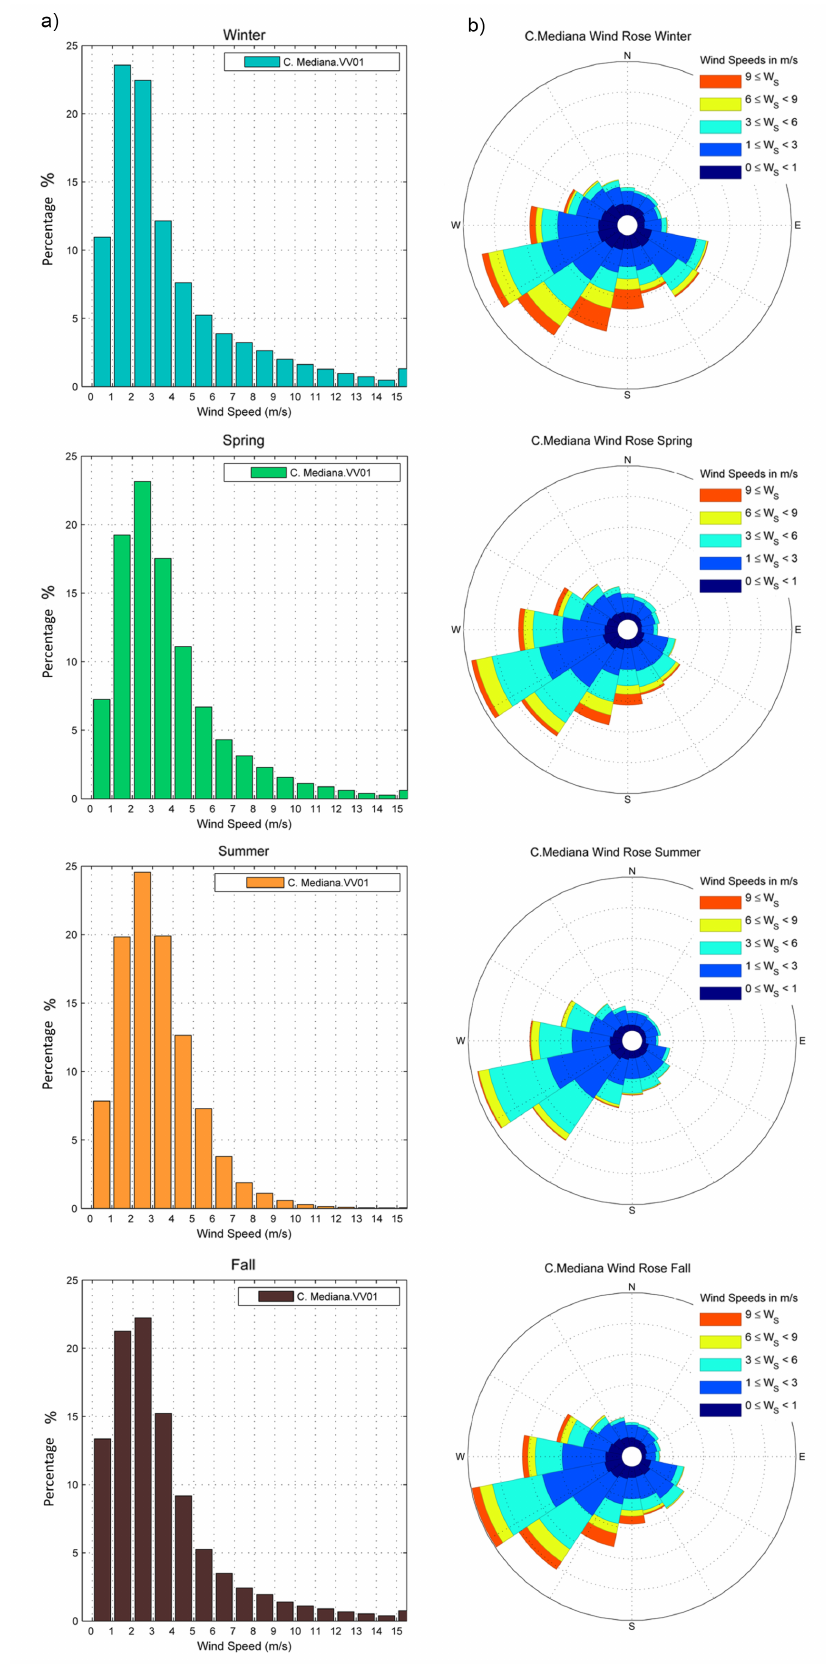
Figure 10. ( a ) Seasonal wind speed distribution at Cabeza Mediana for the period 2000–2014; ( b ) Seasonal wind rose at Cabeza Mediana for the period